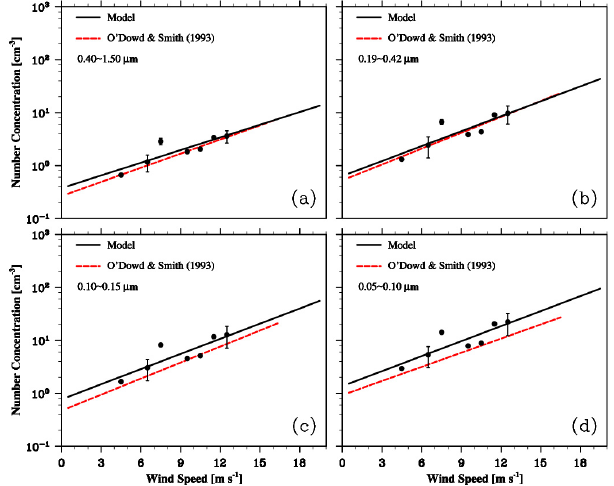
Fig. 11. Wind speed dependence of the number concentration in the model compared with measurements by O’Dowd and Smith (1993) during October 1994 in the Northeast Atlantic (63 ◦ N, 8 ◦ W) in the dry radius range (a) 0.40–1.50µm, (b) 0.19–0.42µm, (c) 0.10– 0.15µm, and (d) 0.05–0.10µm. The dots are the modeled number with error bars representing one standard deviation. The solid lines are the linear fits. The model used the CMS source function and a solubility factor of 0.5.